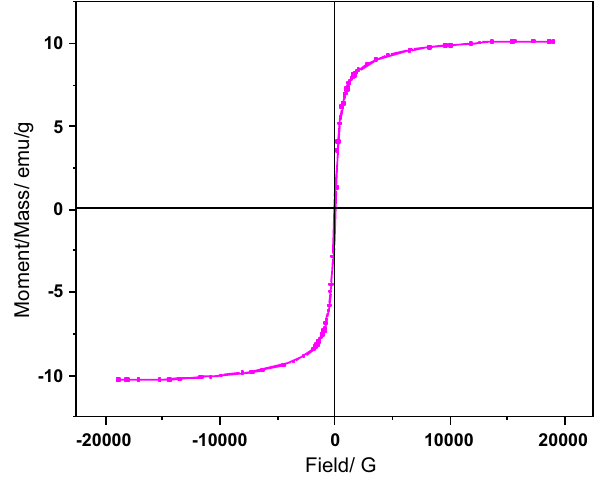
Fig. 5 Magnetic properties through vibrating sample magnetometer analysis of sawdust/magnetite (SF-(2:1)) nanocomposite exhibiting the coercivity (Hci) and retentivity (Mr) value of magnetite nanopar-